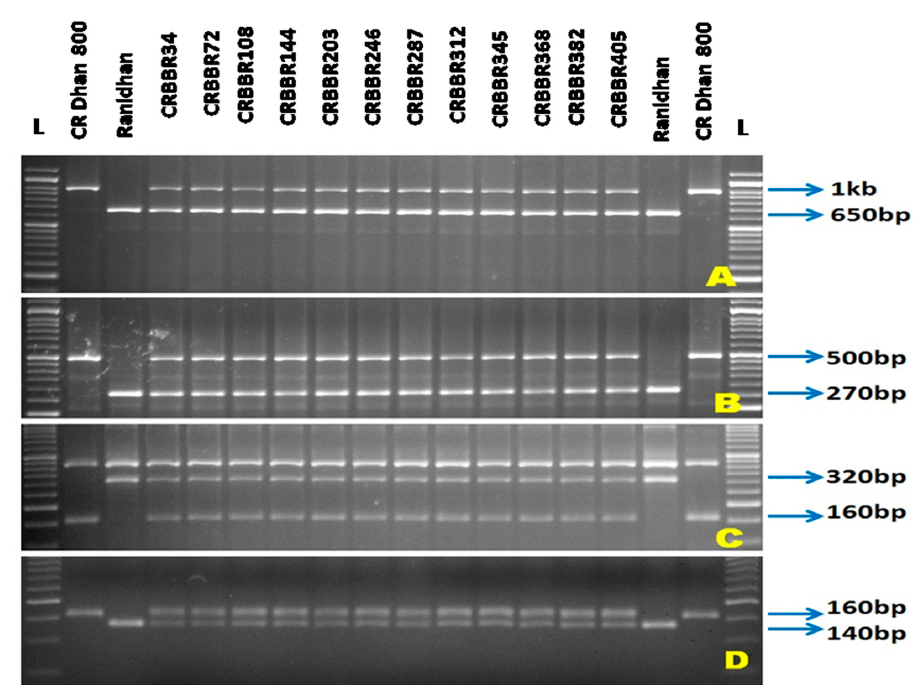
Figure 2. Electropherogram of BC 1 F 1 derivatives of rice variety Ranidhan for four BB resistance genes Xa21 , xa13 , xa5, and Xa4 using markers. ( A ) pTA248; ( B ) Xa-13 prom; ( C ) xa5S/R (Multiplex); Figure 2 ( D ) MP-Nbp-131. Lane 1, 18: 50 bp ladder; Lane 2, 17: CR Dhan 800; Lane 3, 16: Ranidhan; Lane 4–15: BC 1 F 1 derivatives of rice variety, Ranidhan.